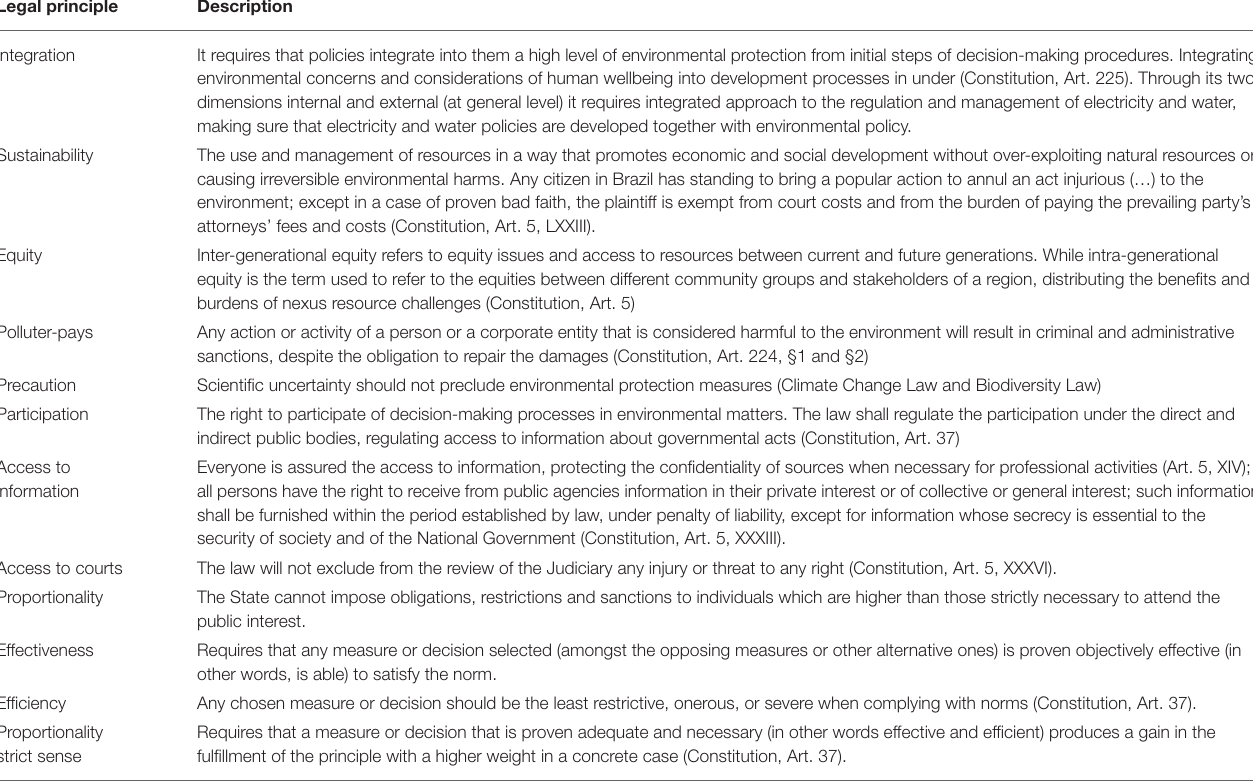
TABLE 4 | Non-exhaustive list of legal principles in Brazil applicable to the water-electricity